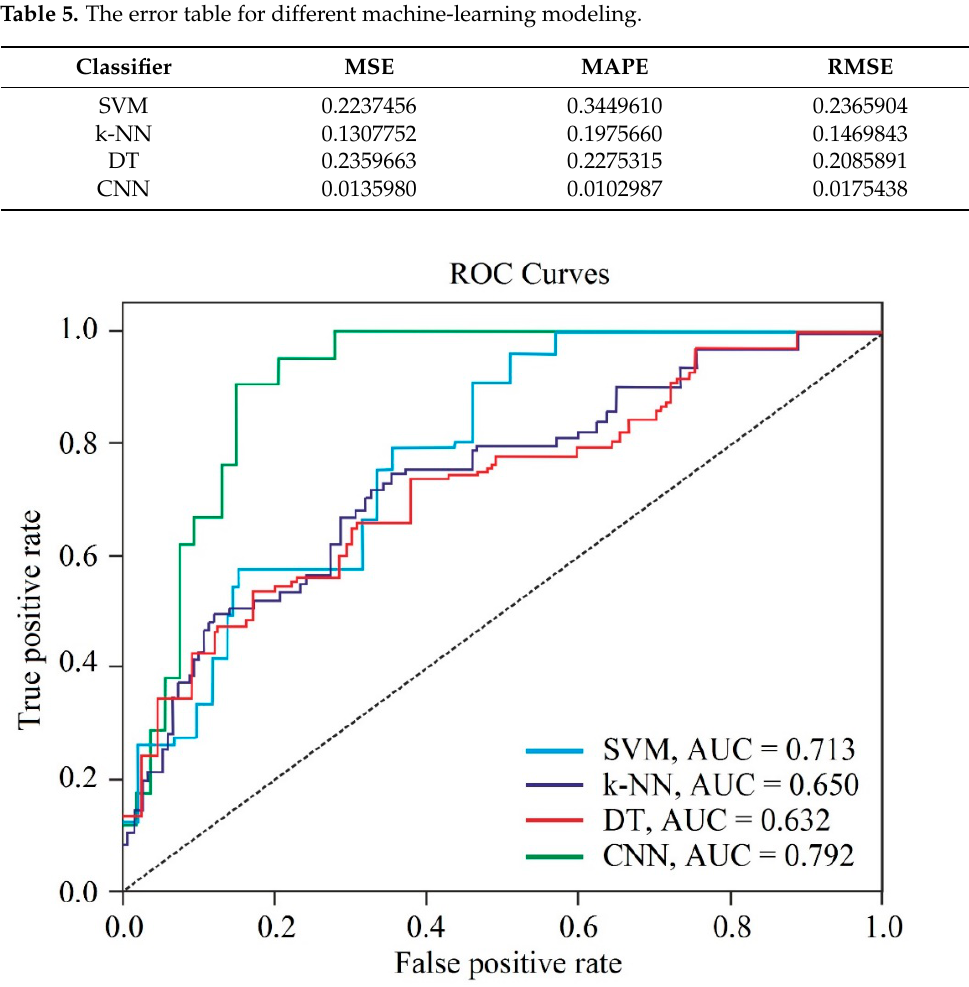
Figure 15. ROC results for all machine-learning models in susceptibility assessment.